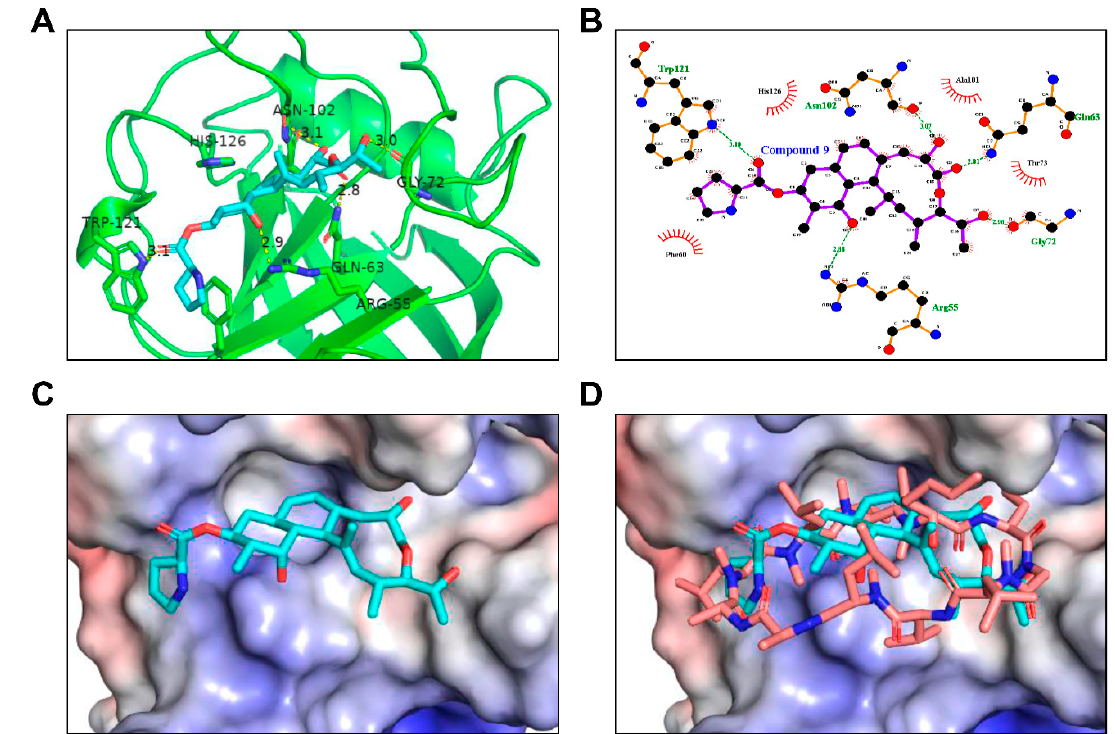
Figure 11. In silico docking analysis of interaction between compound 9 and CypA. ( A – C ) The docking model of compound 9 to CypA obtained from the AutoDock Vina 1.1.2 programs. ( D ) Comparison of the proposed binding model of compound 9 and cyclosporin A. Compound 9 is indicated in cyan and cyclosporin A in brown.